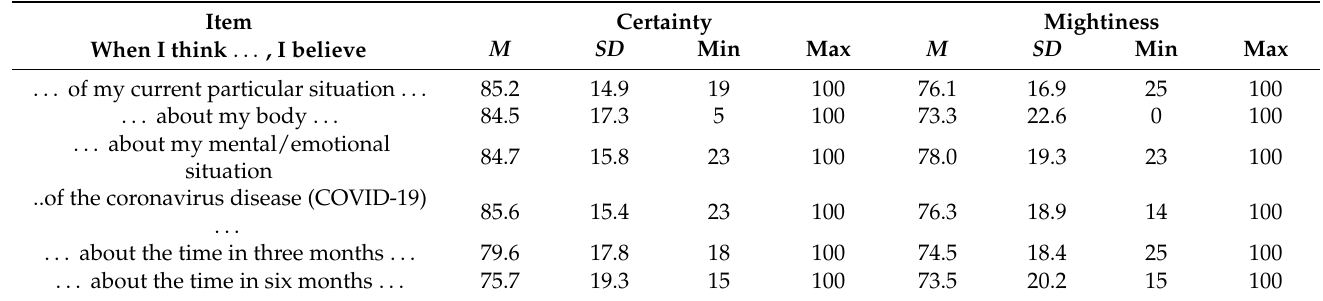
Table 3. Descriptive statistics of certainty and mightiness across the items in the Believing Questionnaire.